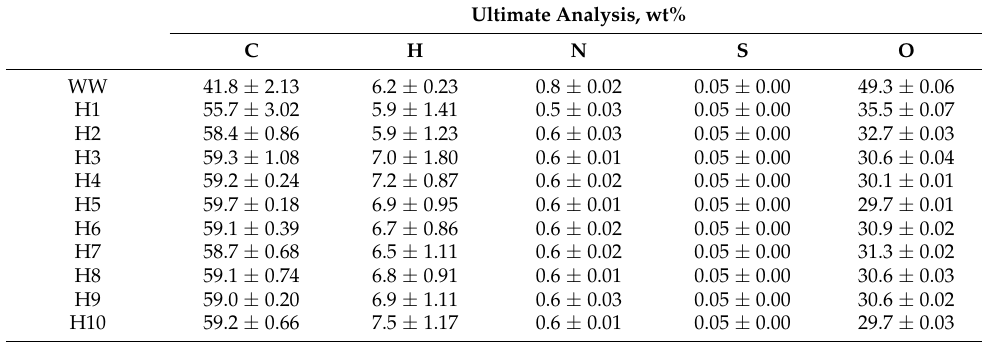
Table 2. Ultimate analysis of biomass and hydrochar.